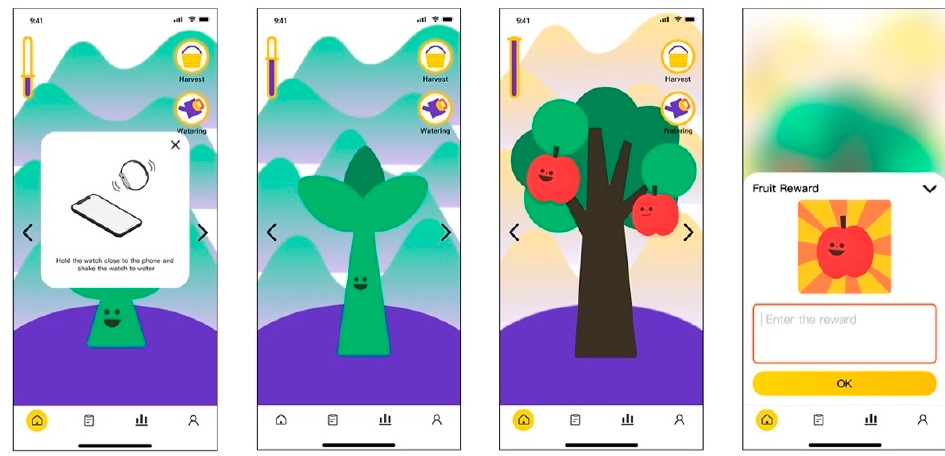
Figure 13. Gamification feedback: My Garden.